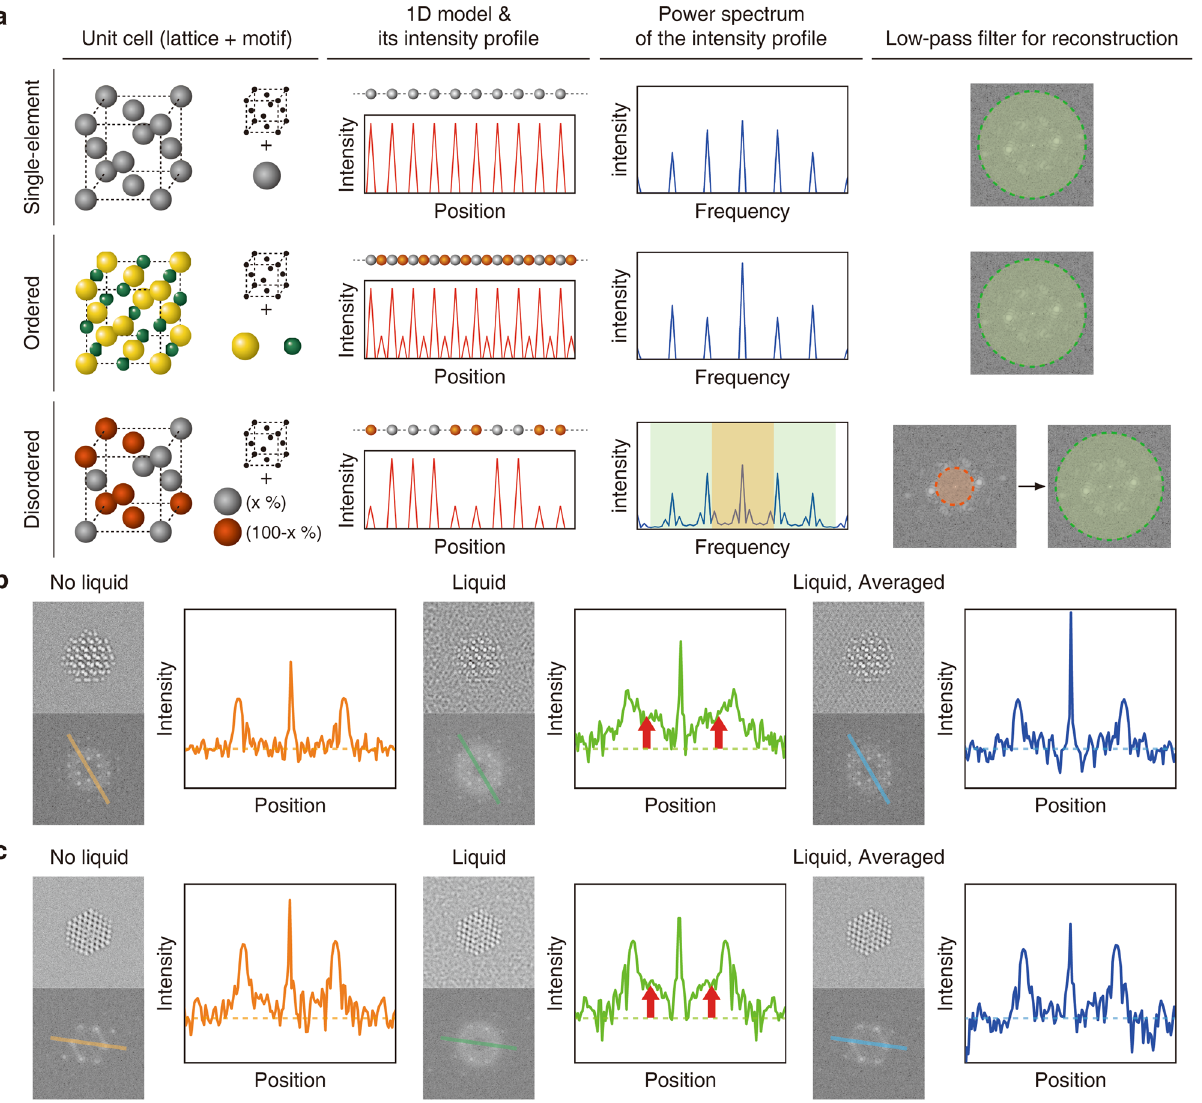
disordered multi-element systems. ( b – c ) Simulated TEM images of multi-element nanoparticles, their 2D power spectra, and corresponding line profiles for nanoparticles without liquid (left, orange), with liquid (medium, green), and with liquid and averaging (right, blue). The line profiles are extracted from marked lines on the 2D power spectrum images. ( b ) ordered multi-element nanoparticles (zinc blende CdSe), ( c ): disordered multi- element nanoparticles (disordered fcc